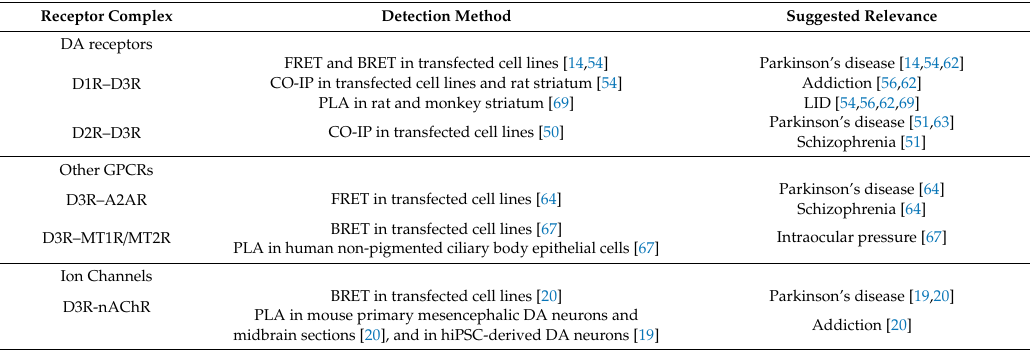
Table 1. Heteromeric complexes containing the